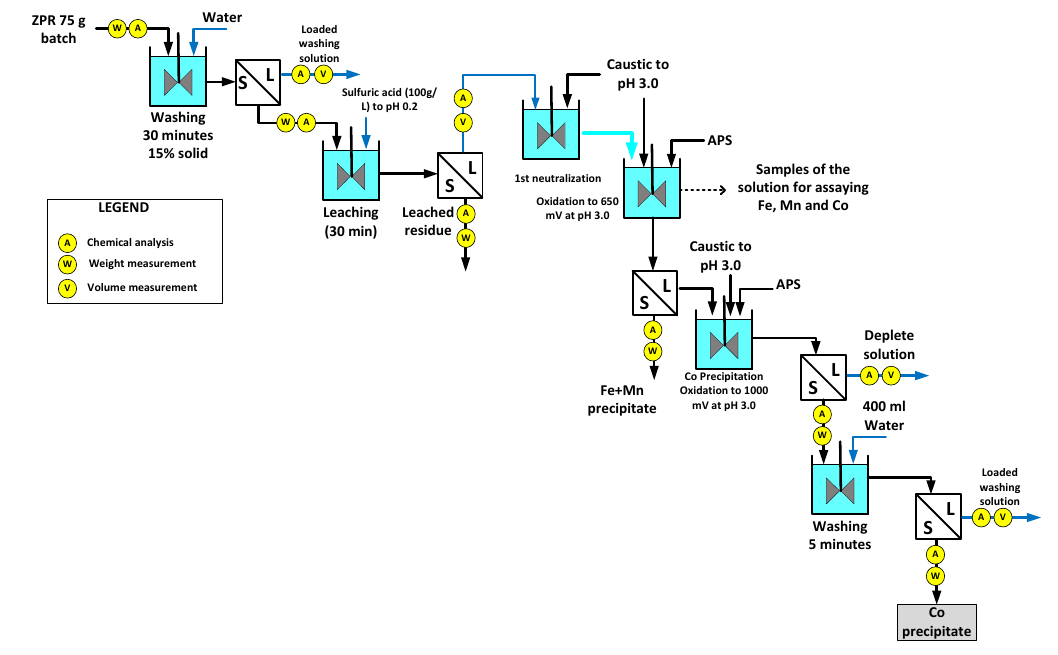
Figure 6. Process for the extraction of cobalt from the ZPR.